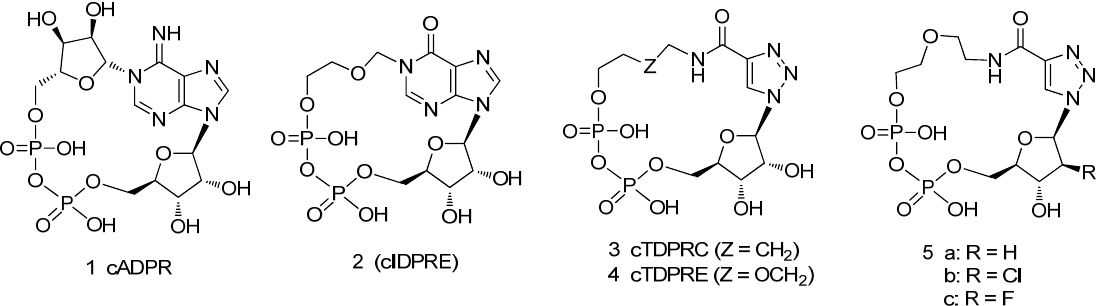
Figure 1. Structures of cADPR